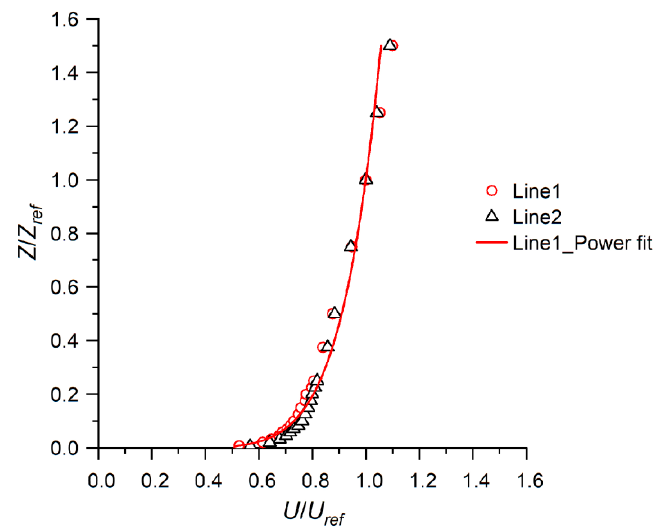
Figure 6. Comparison of vertical ( Z ) profiles of streamwise air velocity ( U ) measured at Line 1 and Line 2. U ref is the reference streamwise velocity at the reference height Z ref . The red line is the power fit of the wind profile measured at Line 1.